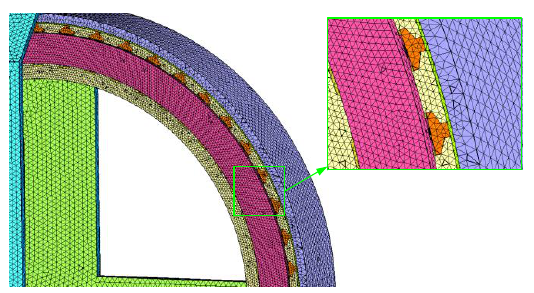
Figure 5. Mesh generation of the model.